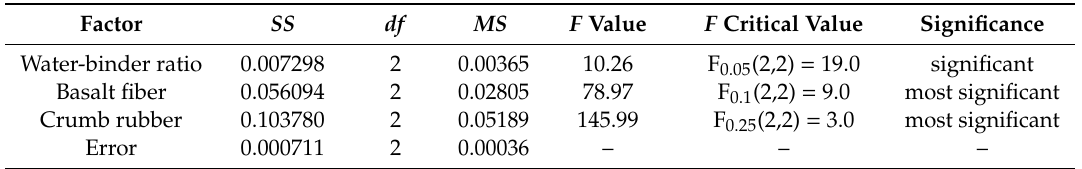
Table 13. Variance analysis for RCH .